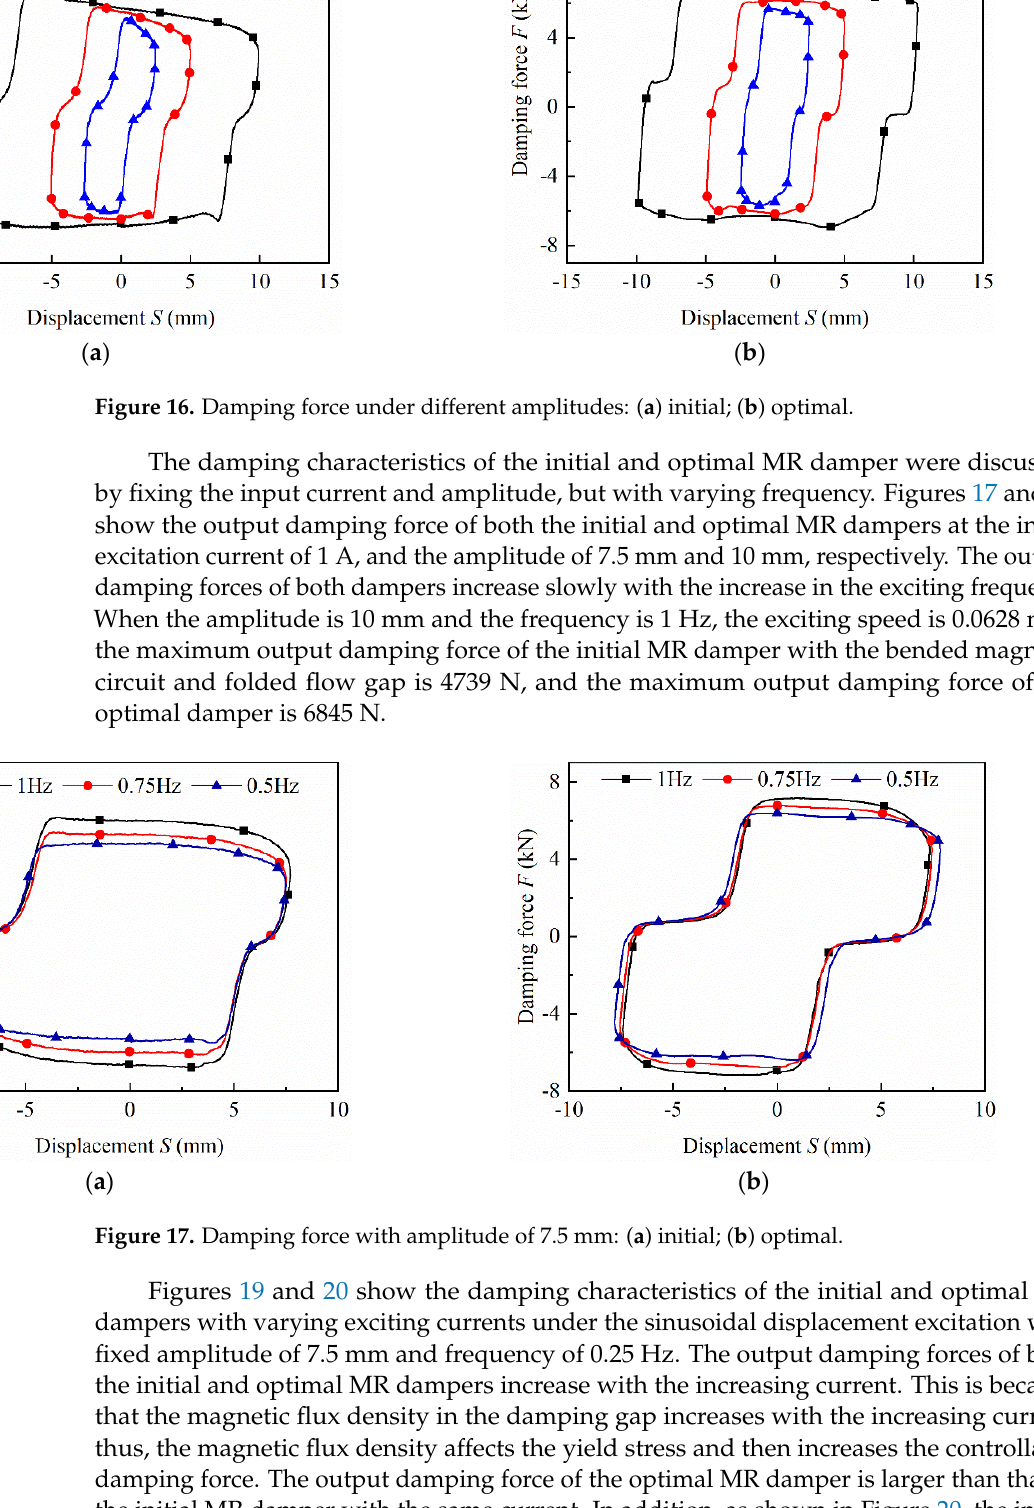
Figure 18. Damping force with amplitude of 10 mm: ( a ) initial; ( b )